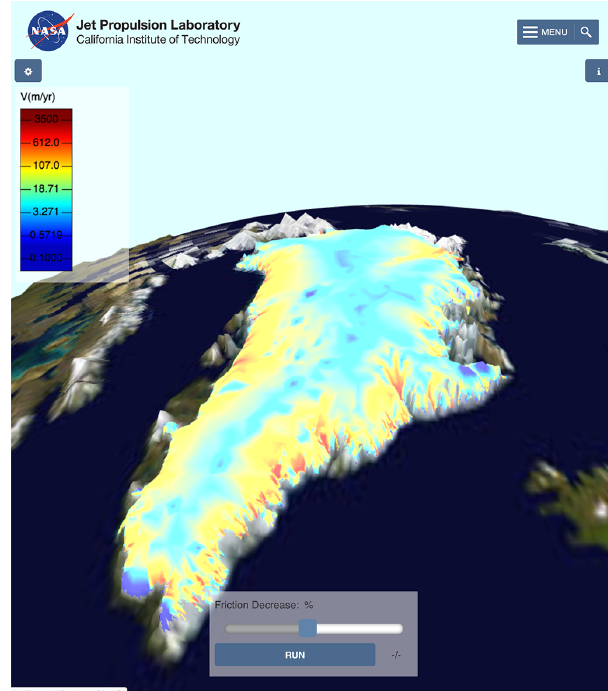
Figure 3. Columbia Glacier ISSM simulation on the Virtual Earth System Laboratory (https://vesl.jpl.nasa.gov). This particular sim- ulation allows for the introduction of user-driven SMB anomalies (using a slider ranging from − 5 to + 5ma − 1 ) on the transient ice flow of Columbia Glacier. The computations (upon clicking of the RUN button) are carried out on the ISSM computational server (where the model inputs are uploaded and from which the results are downloaded locally to the client’s web browser). The transient results are displayed as a movie, which can be controlled via user interface (UI) controls. The interactive rendering of the velocity and thickness fields is done in 3-D (or 2-D, upon click- ing of a toggle button) using the ISSM WebGL rendering engine. The results are overlaid on a semitransparent topographical ren- dering of the Shuttle Radar Topography Mission (SRTM) digi- tal elevation model (DEM), and a background geotiff image from A. Gardner, M. Fahnestock, and E. Larour (personal communica- tion, 2016). Model information can be displayed by clicking the info button, allowing for extensive information on the model setup and the datasets used to constrain the simulation.